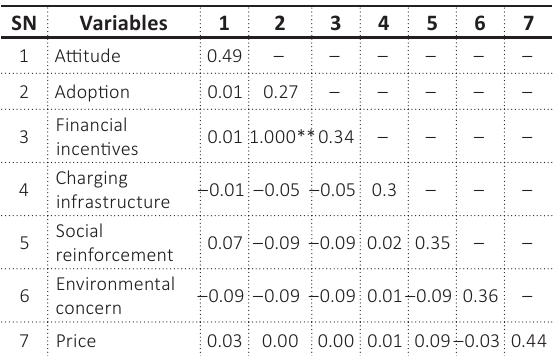
Table 4. Discriminant validity (Fornell-Larcker